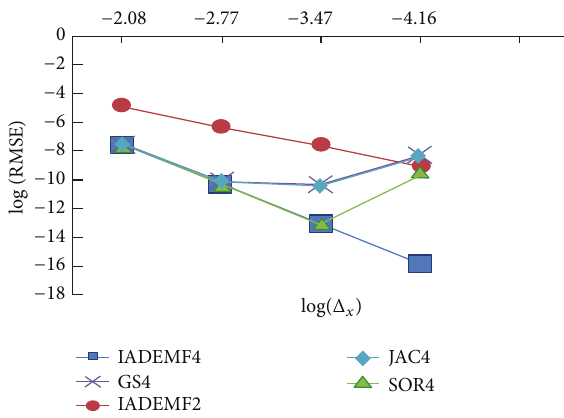
Figure 10: Log(RMSE) versus Log (Δ𝑥) Experiment 2. Δ𝑡 = 0.0001 , 𝑡 = 0.002 , and 𝜀 = 10 −4 .